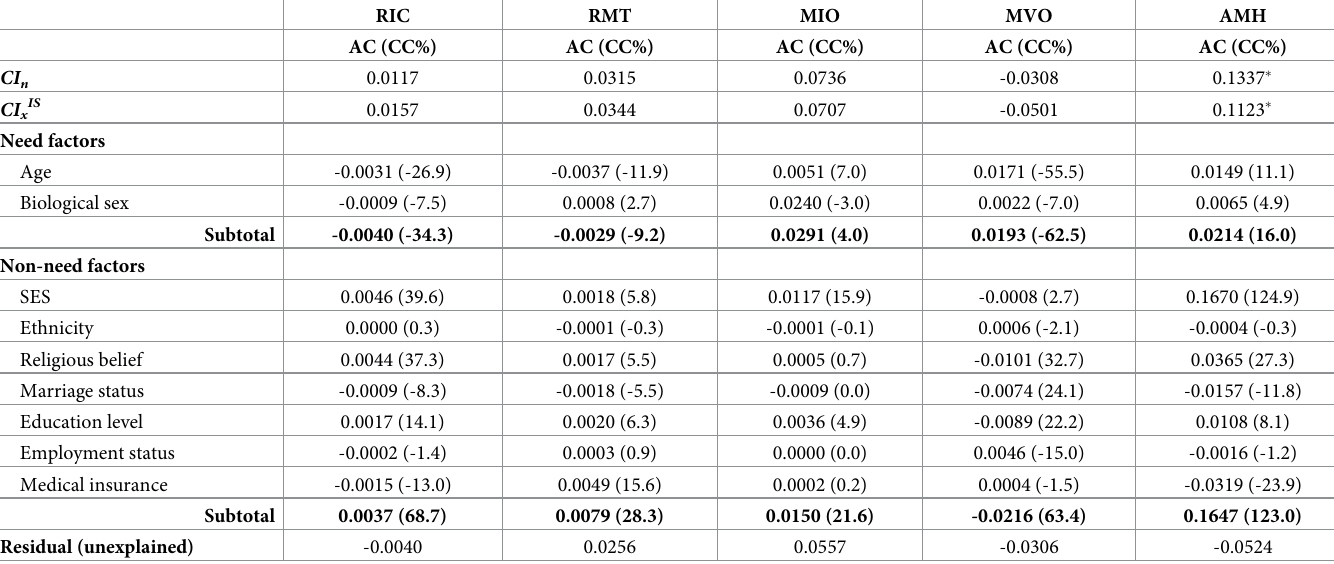
Table 3. Concentration index and aggregated contribution of regressors to concentration indices for HIV care